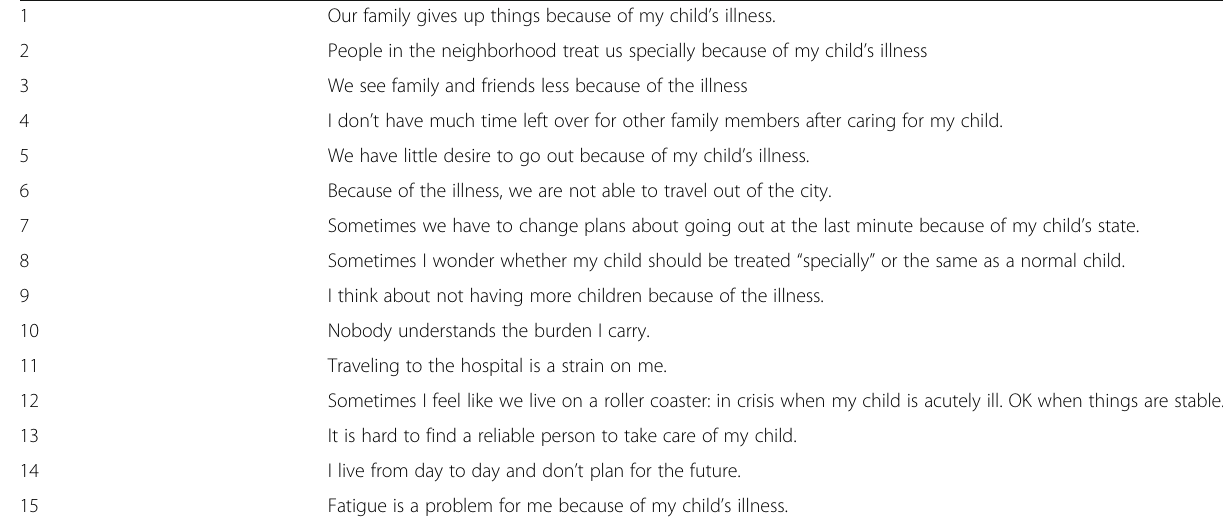
Table 1 English version of the